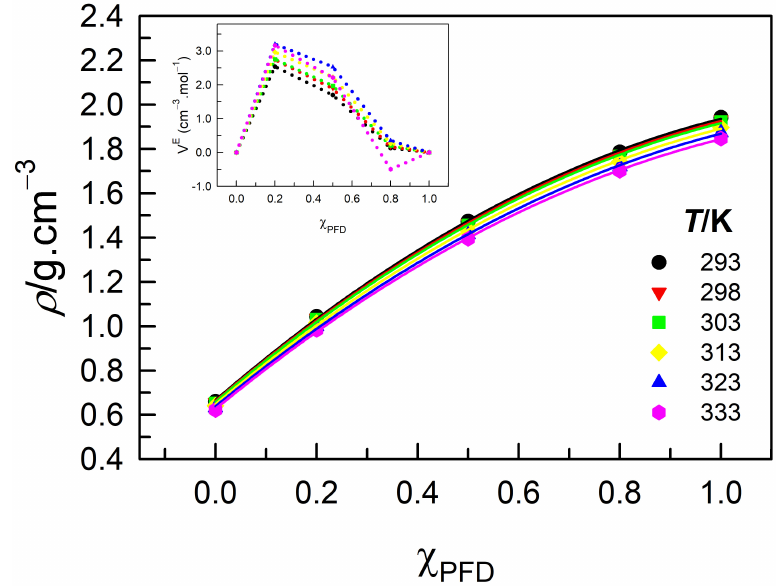
Figure 3. Variation in densities of the investigated mixtures with varying mole ratios of the con- stituents at different temperatures ( T = 293 to 333 K) and at pressure p = 0.1 MPa. The solid line represents fit to the equation ρ /(g · cm − 3 ) = ρ 0, x b , and c , along with R 2 , are provided in Table